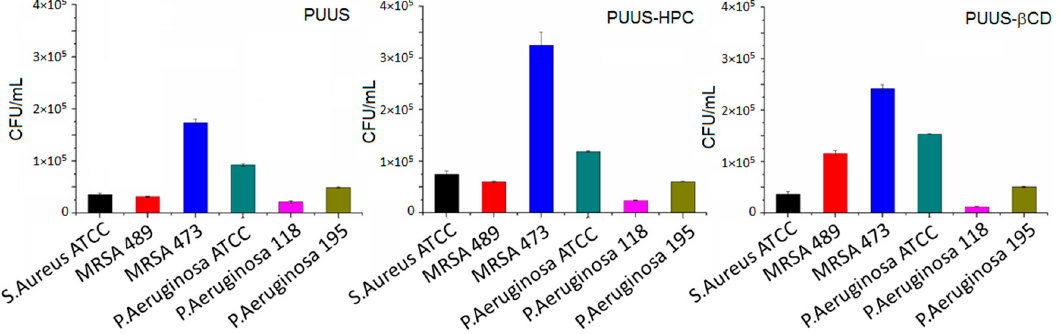
Figure 12. Different bacterial adhesion on nanofibrous mat (PUUS) and nanofibrous composite mats (PUUS-HPC and PUUS- β CD).